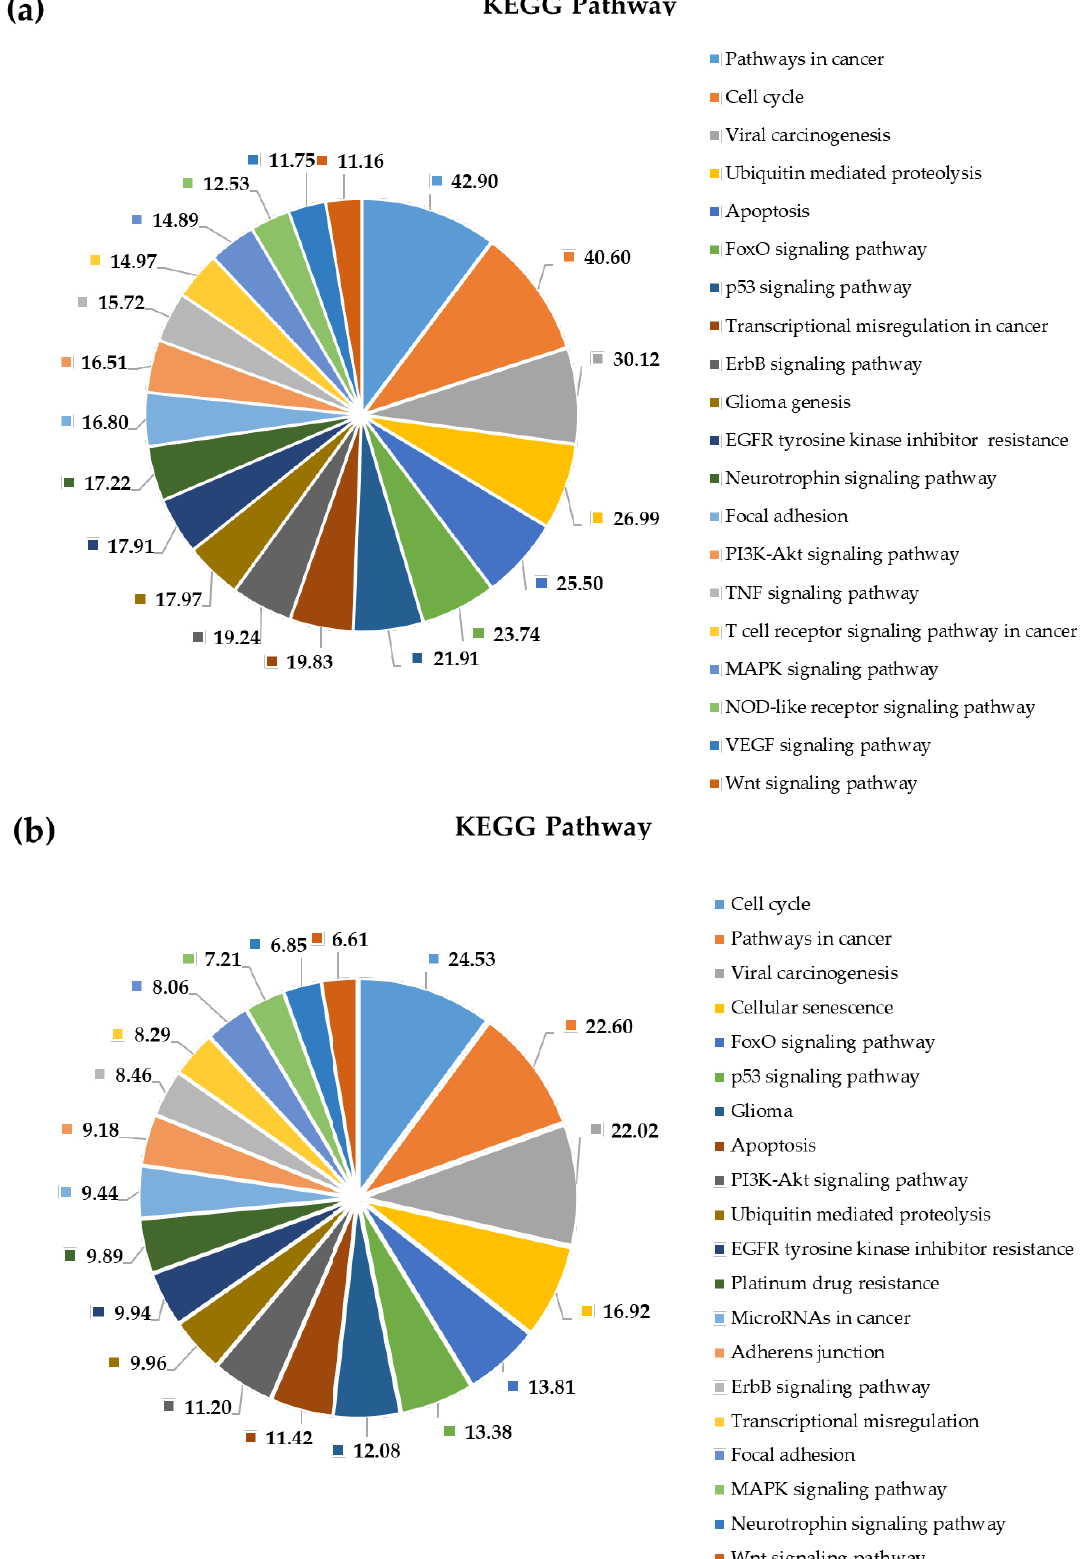
Figure 9. GO molecular function – based general ( a ) and cortex-specific ( b ) functional enrichment annotation of all target genes of differentially expressed miRNAs applying the NetworkAnalyst tool. Significance of the selected (?) pathways are characterized by their FDR values shown inside the chart sections.